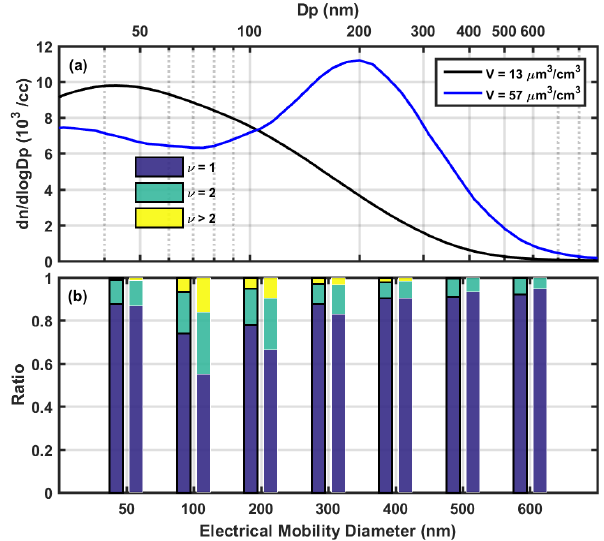
Figure 1. (a) Two particle number size distributions (PNSDs) ob- served during field measurements. The black line is the distribution during a period of relatively clean air, and the blue line is the distri- bution during a period of heavy air pollution. (b) The number ratio of particles carrying different charges for each PNSD. For each di- ameter, the left bar corresponds to the PNSD shown in black in (a) , while the right bar corresponds to the PNSD shown in